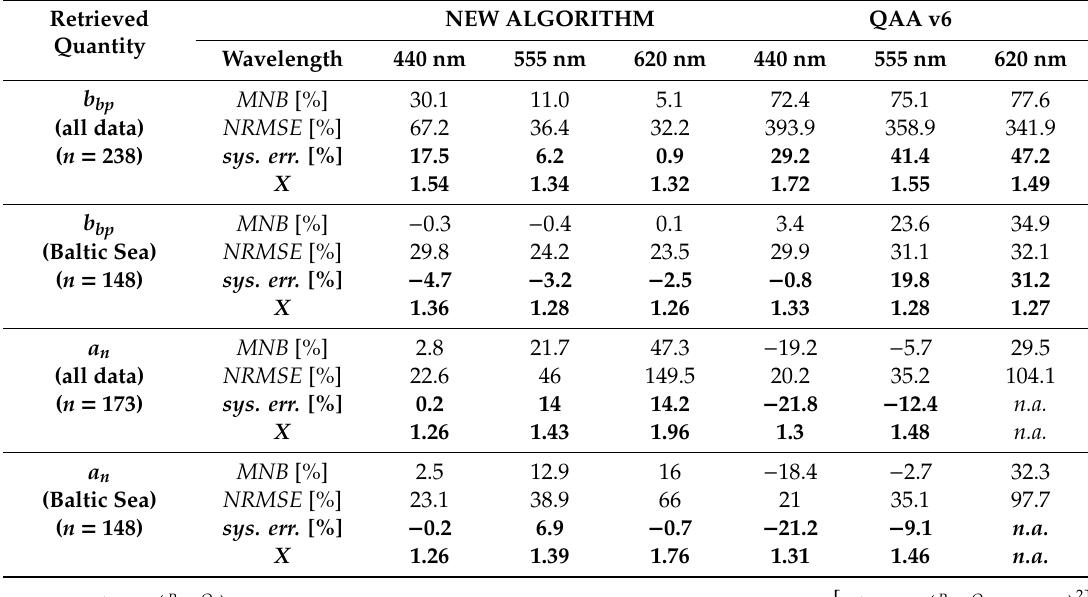
Table 2. Summary of estimation errors of coe ffi cients b bp and a n obtained when the new algorithm (formulated in this work) and the standard quasi-analytical algorithm (QAA) (according to Lee et al. [5]; version 6 [37]) were applied to the entire dataset used in this work, as well as to the subsets representing the Baltic Sea data. The statistical parameters calculated according to arithmetic statistics: the mean normalized bias ( MNB ) 1 and the normalized root mean square error ( NRMSE ) 2 ; the parameters calculated according to logarithmic statistics: the systematic error ( sys.err. ) 3 and the standard